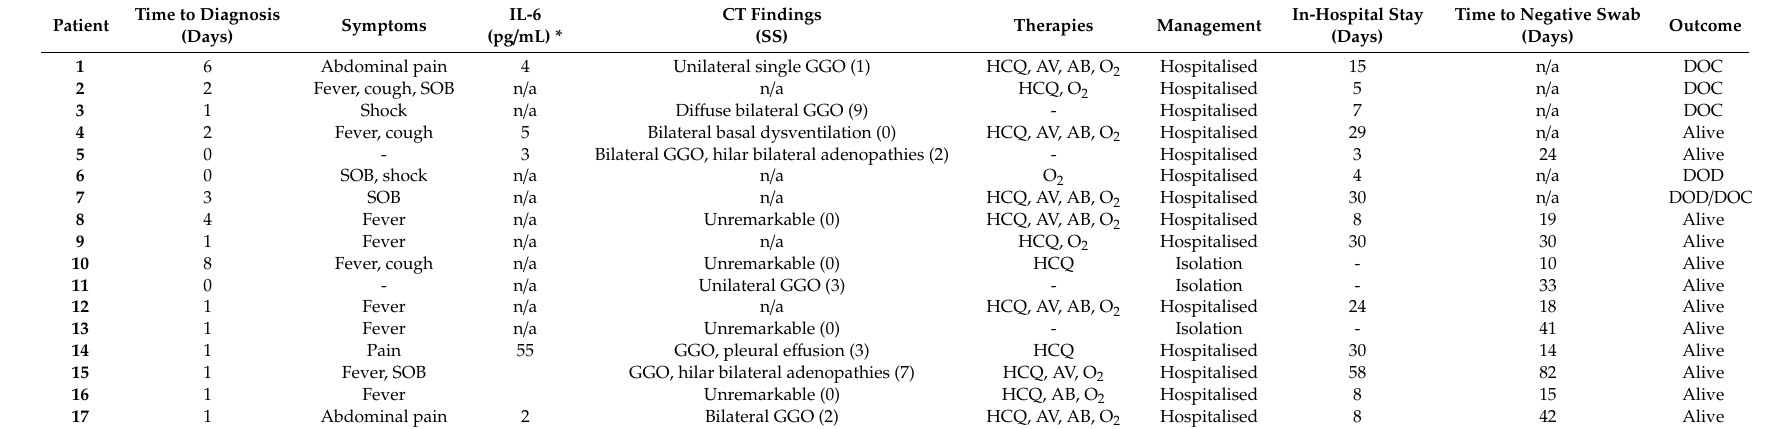
Table 3. Characteristics of SARS-CoV-2 infection in cancer patients on active treatment.